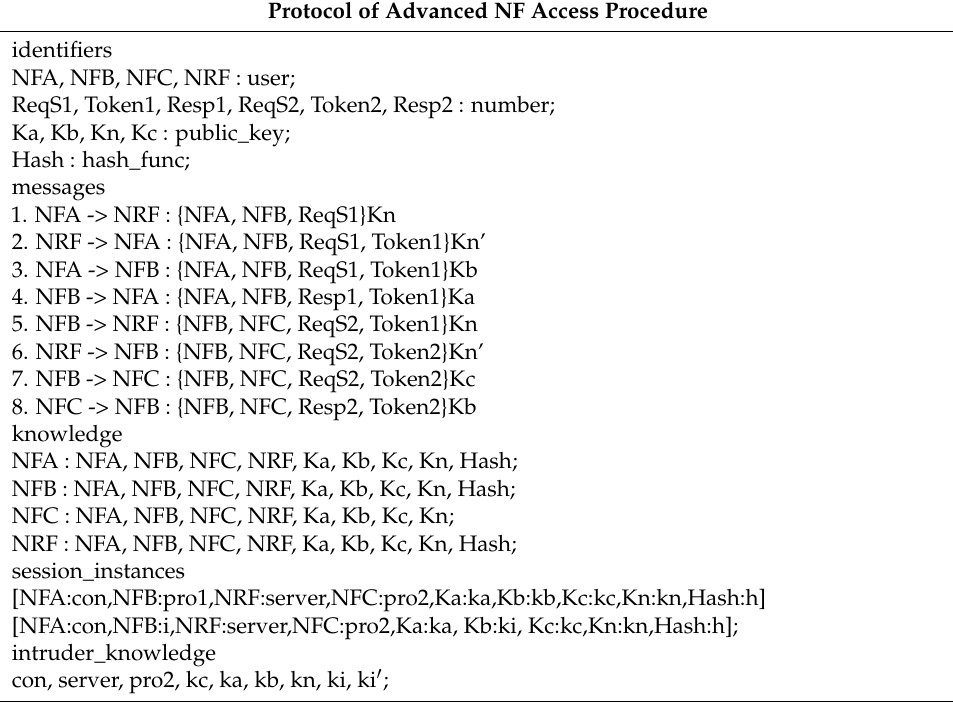
Table 9. CAS+ description of the advanced service access procedure. Protocol of Advanced NF Access